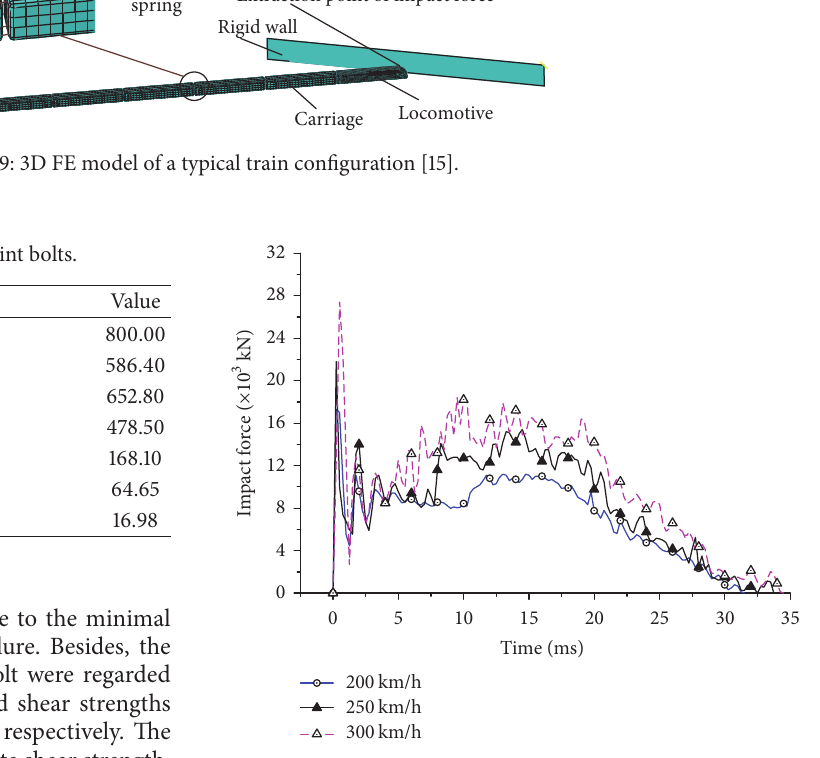
Figure 10: Impact force of a train (with running speeds of 200